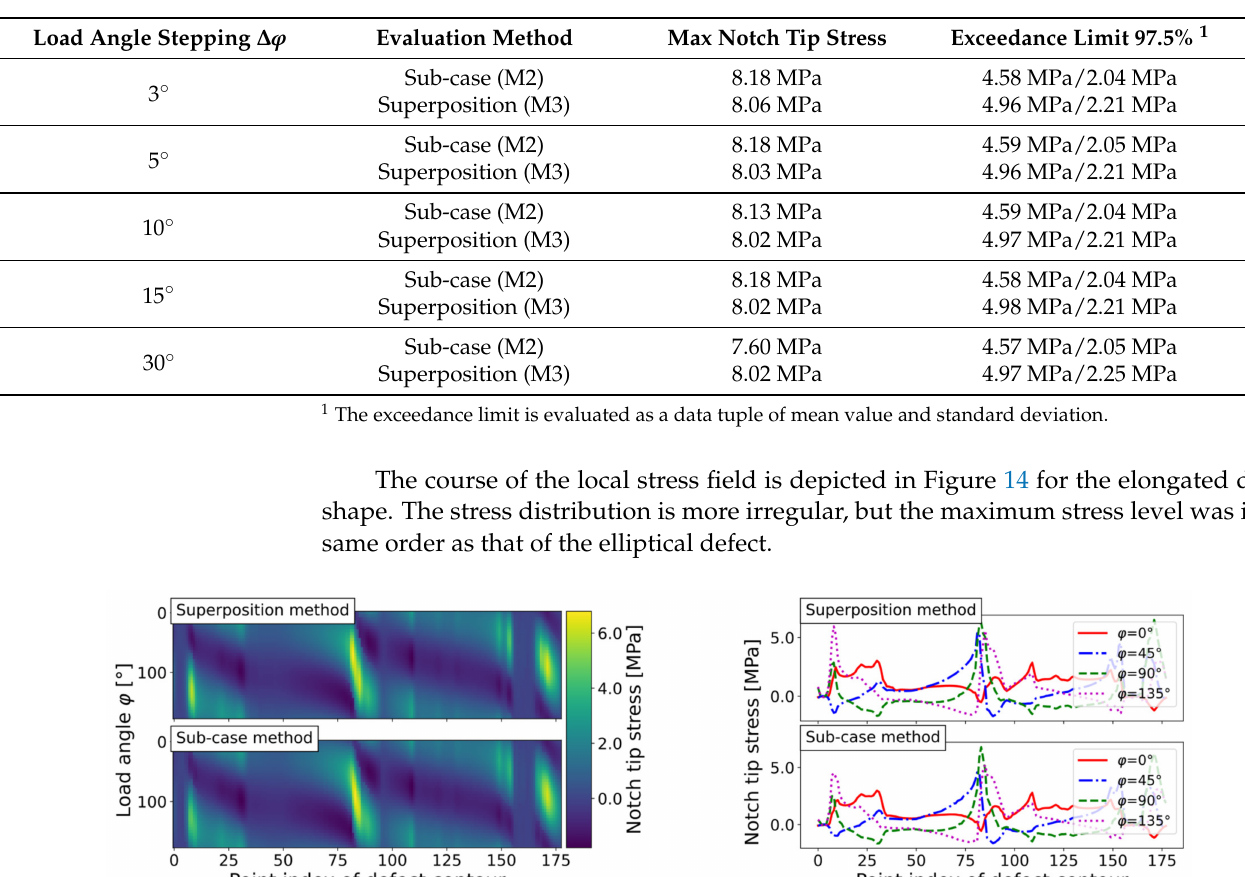
Table 6. Effect of load angle stepping on evaluated stress distribution of coarse-meshed elliptical hole-in-plate (refer to Figure 7b) for sub-case and superposition methods.